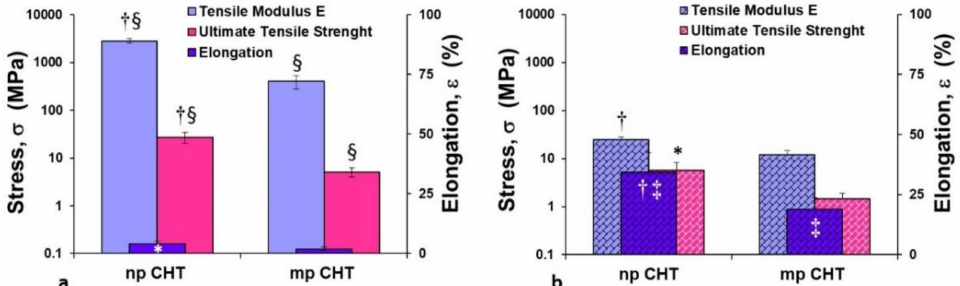
Figure 4. Mechanical properties of nanoporous (np CHT) and microporous (mp CHT) chitosan membranes in dry ( a ) and wet ( b ) conditions. The values are the means of 10 measurements per sample ± SD. Data are statistically significant according to Student’s t-test: (†) p < 0.01 and (*) p < 0.05, vs. mp CHT, in the same dry or wet conditions; (§) p < 0.01 vs. wet condition on the same substratum; (‡) p < 0.01 vs. dry condition on the same